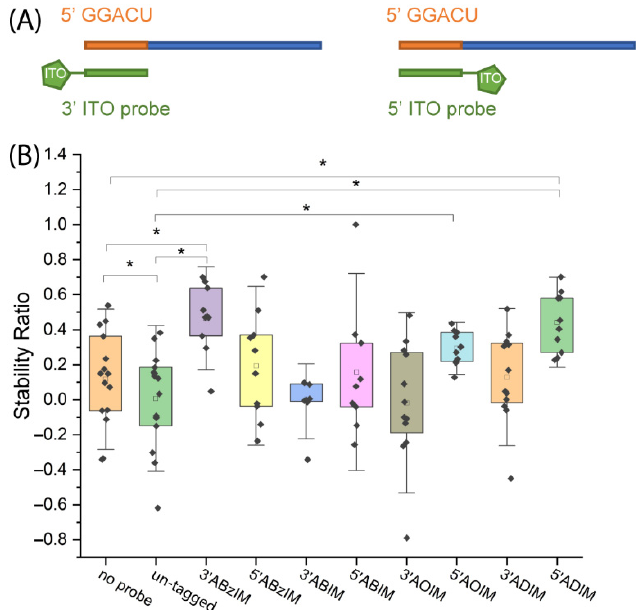
Figure 5. ( A ) Schematic representation of RNA target and 3 ′ or 5 ′ ITO probes. ( B ) Comparison of stability ratios obtained for ITOs with 3 ′ or 5 ′ functional groups when applied in a nuclease protection assay involving a 15-mer RNA standard with a 5 ′ terminal GGACU motif target. Within each box plot (25th to 75th percentile), the small square in each box represents the mean of the data. Individual data points are represented by black diamonds. Error bars are 1.5 SD, unpaired t -test, * p < 0.05.